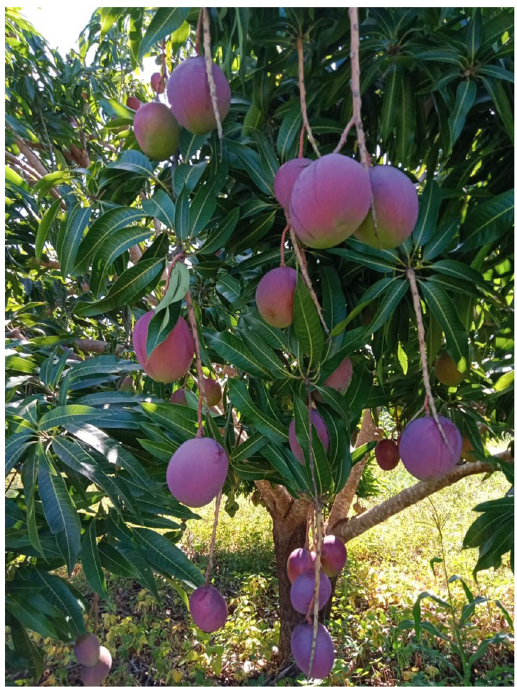
Figure 2: Mango fruit tree ( Mangifera indica ) in Kasafari, Embu County. Mango is the most popular fruit tree grown across the three counties. Mango is commonly grown in Eastern Kenya for commercial